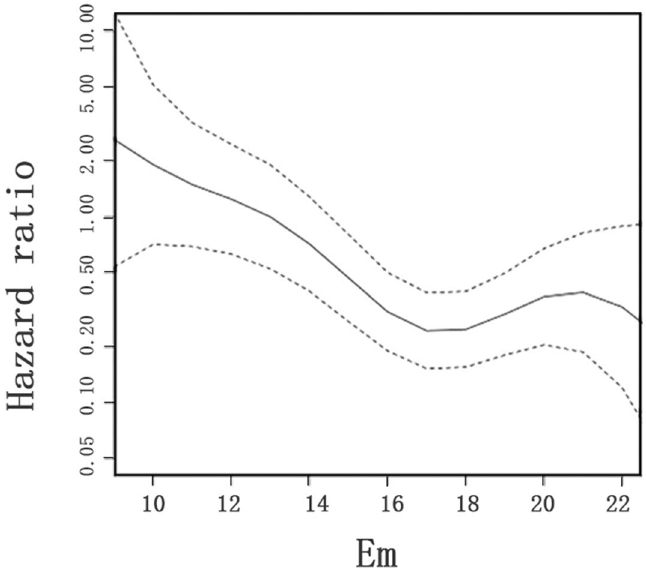
Figure 3. Correlation between Em and the risk of pre-eclampsia among pregnant women. Penalized smoothing spline (P-splines) and univariate cox proportional hazards method were used to assess the tendency of the occurrence rate of pre-eclampsia. Em < 13 cm/s was strongly correlated with pre-eclampsia occurrence (HR 8.56; 95% CI 3.40–21.57) after being adjusted for the confounders (age, parity, gestational week, LVEF, LAVI). Correlation between Em and the risk of pre-eclampsia occurrence was shown in Figure. There was a tendency that larger Em value was associated with lower hazard